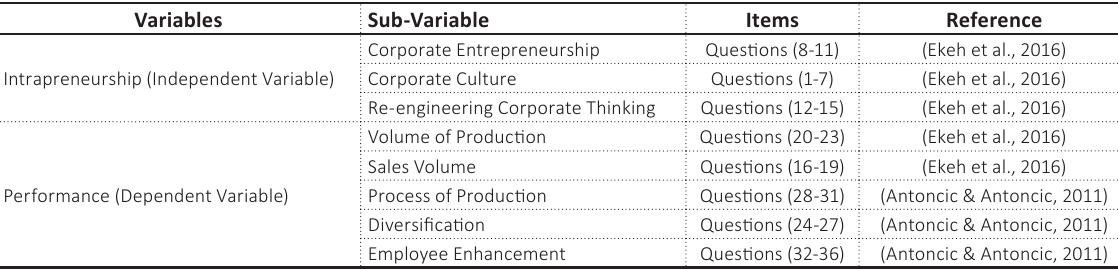
Table 1. Sources of